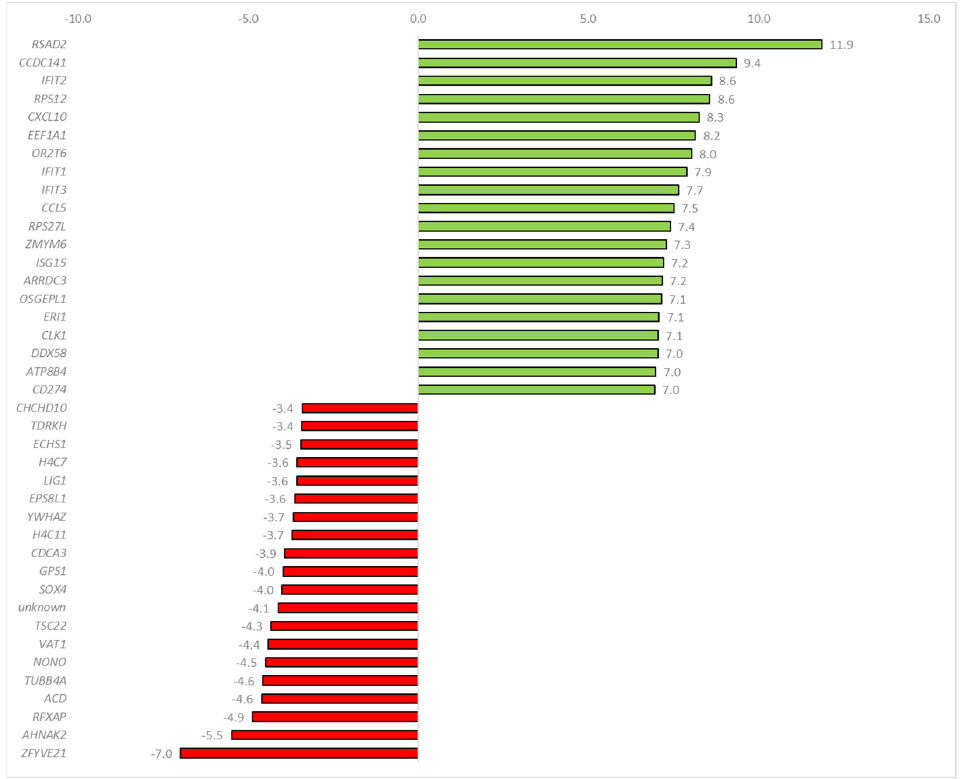
Figure 4. Protein − coding RNAs that exhibited the highest over − and underexpression in exosomes released from influenza − infected MDCK cells.